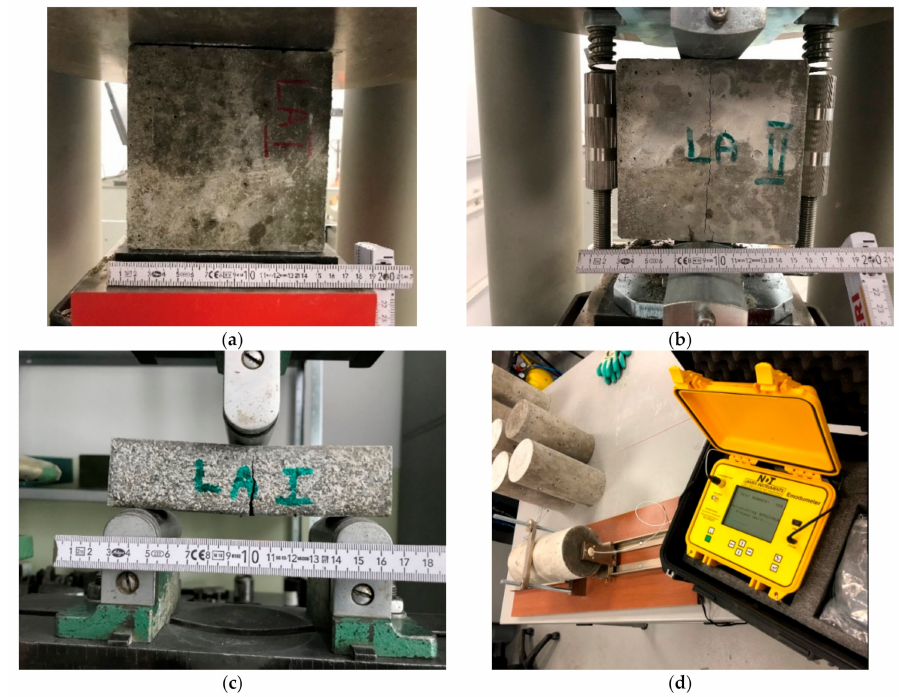
Figure 3. Photographic documentation of tests carried out: ( a ) compressive strength test, ( b ) split tensile strength test, ( c ) flexural strength test, ( d ) elastic modulus test.